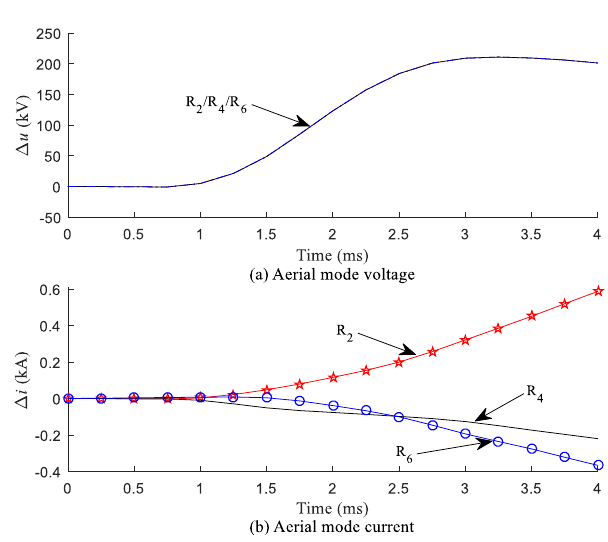
Figure 8. The aerial mode components that were detected by R 2 , R 4 , and R 6 for a fault at f 1 on busbar I: the ( a ) aerial mode voltage and the ( b ) aerial mode current. Table 1. Simulation results for a typical internal fault on busbar I.